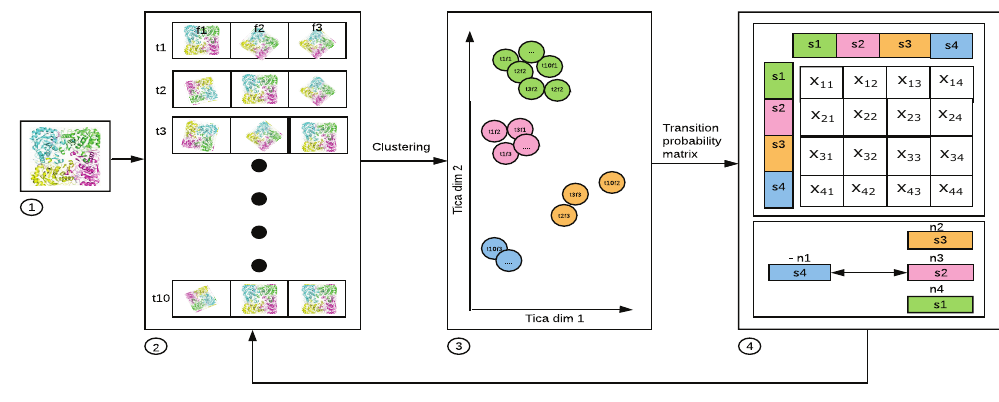
Figure 2 1. Starting structure (frames f) of the bio-molecule used for parallel simulation. 2. 10 (ar- bitrary number for illustration) parallel trajectories (t1 through t10) produced by MD software, such as ACEMD, GROMACS,AMBER, etc. 3. The frames per structure, having reduced to 2 dimensions us- ing TICA. 4. MSM constructed with each of the values in a cell of the matrix, x ij , where i is the source state, and j is the destination state showing the probability of transition. from i to j. The figure has been drawn based on Fig. 1 in Husic & Pande (2018) . Full-size DOI: